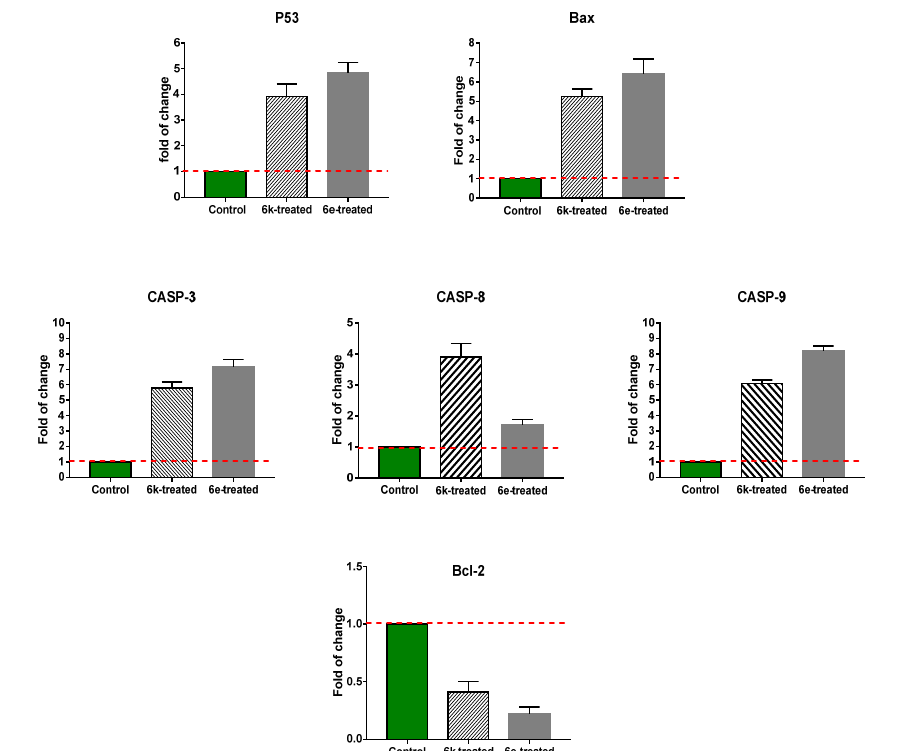
Figure 6. Quantitative RT-PCR results analysis of the apoptosis-related genes; P53, Bax, Caspases 3, 8, 9, and Bcl-2, respectively in MCF-7 cells treated with 6e and 6k with the IC 50 values, 48 h. The data illustrated are the average of 3 independent experimental runs (mean ± SD). Data were normalized using β -actin as a housekeeping gene. Red dashed line represents the gene expression for untreated control. Table 3. Fold change of apoptosis-related genes in untreated and treated MCF-7 cells.